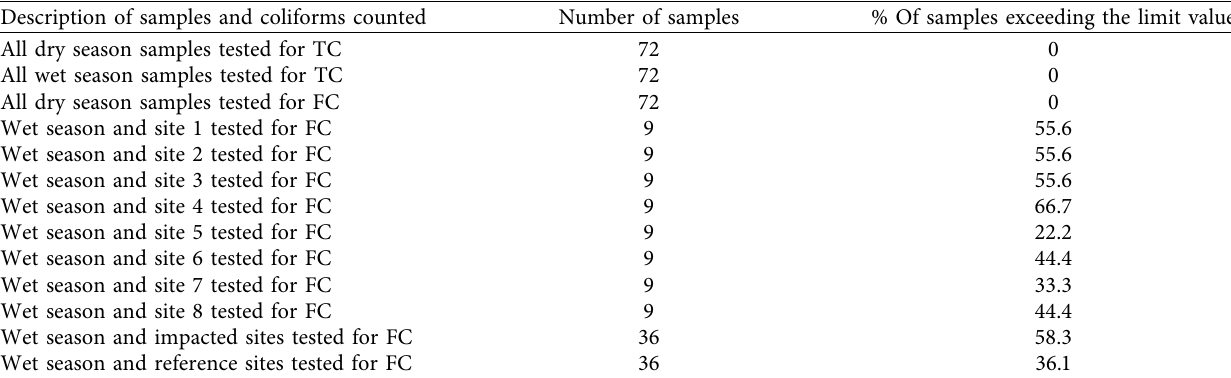
Table 3: Compliance of all water samples collected from all sites in the Southern Gulf of Lake Tana with the guidelines in terms of coliform counts,